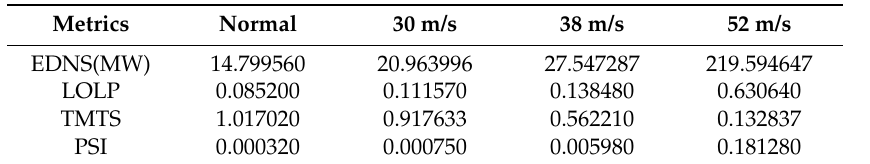
Table 3. Toughness metrics under different wind speeds.